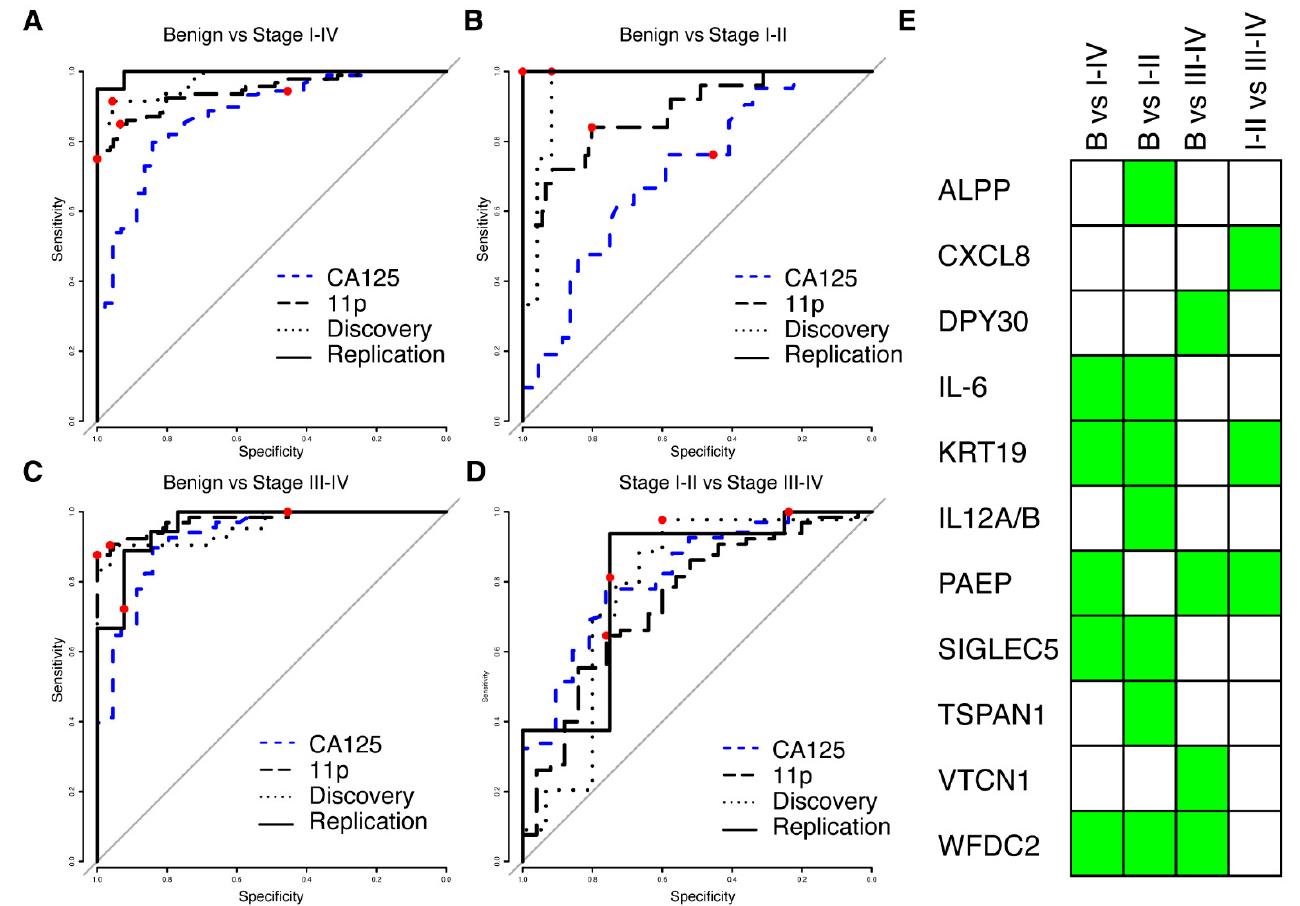
Figure 2. Results from multivariate modelling using the univariate significant biomarkers. ( A ) ROC curve from validation (solid line) and training (dotted line) for separating benign controls from ovarian cancer stages I–IV. The combined performance of clinically measured MUCIN-16 (CA125) in the same cohorts is shown in dashed blue and the performance of the previously developed 11-biomarker panel [15] is shown as a long-dashed black line. In each ROC curve, the point estimate of sensitivity and specificity at a cut-off (‘best-point’ for multivariate models, 35 U/mL for clinical MUCIN-16) is indicated by a red dot. ( B , C ) As ( A ), but for separating benign controls from stages I–II ( B ) and stages III–IV ( C ). ( D ) As ( A ), but for separating ovarian cancer stages I–II from stages III– IV. ( E ) Graphical illustration of the proteins (rows) included in each of the models in A – D (columns). A green box indicates inclusion.